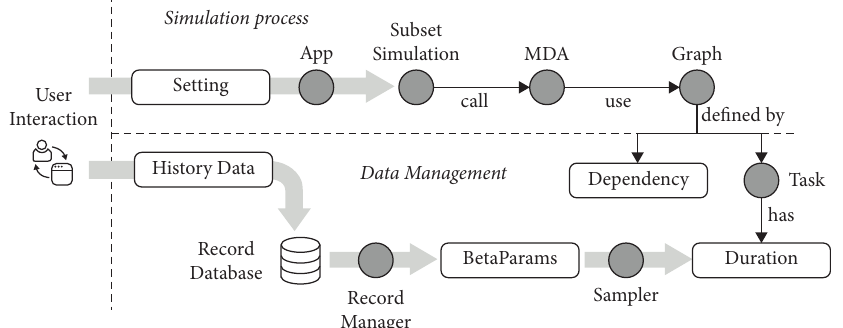
Figure 5: Data flow diagram of our system.